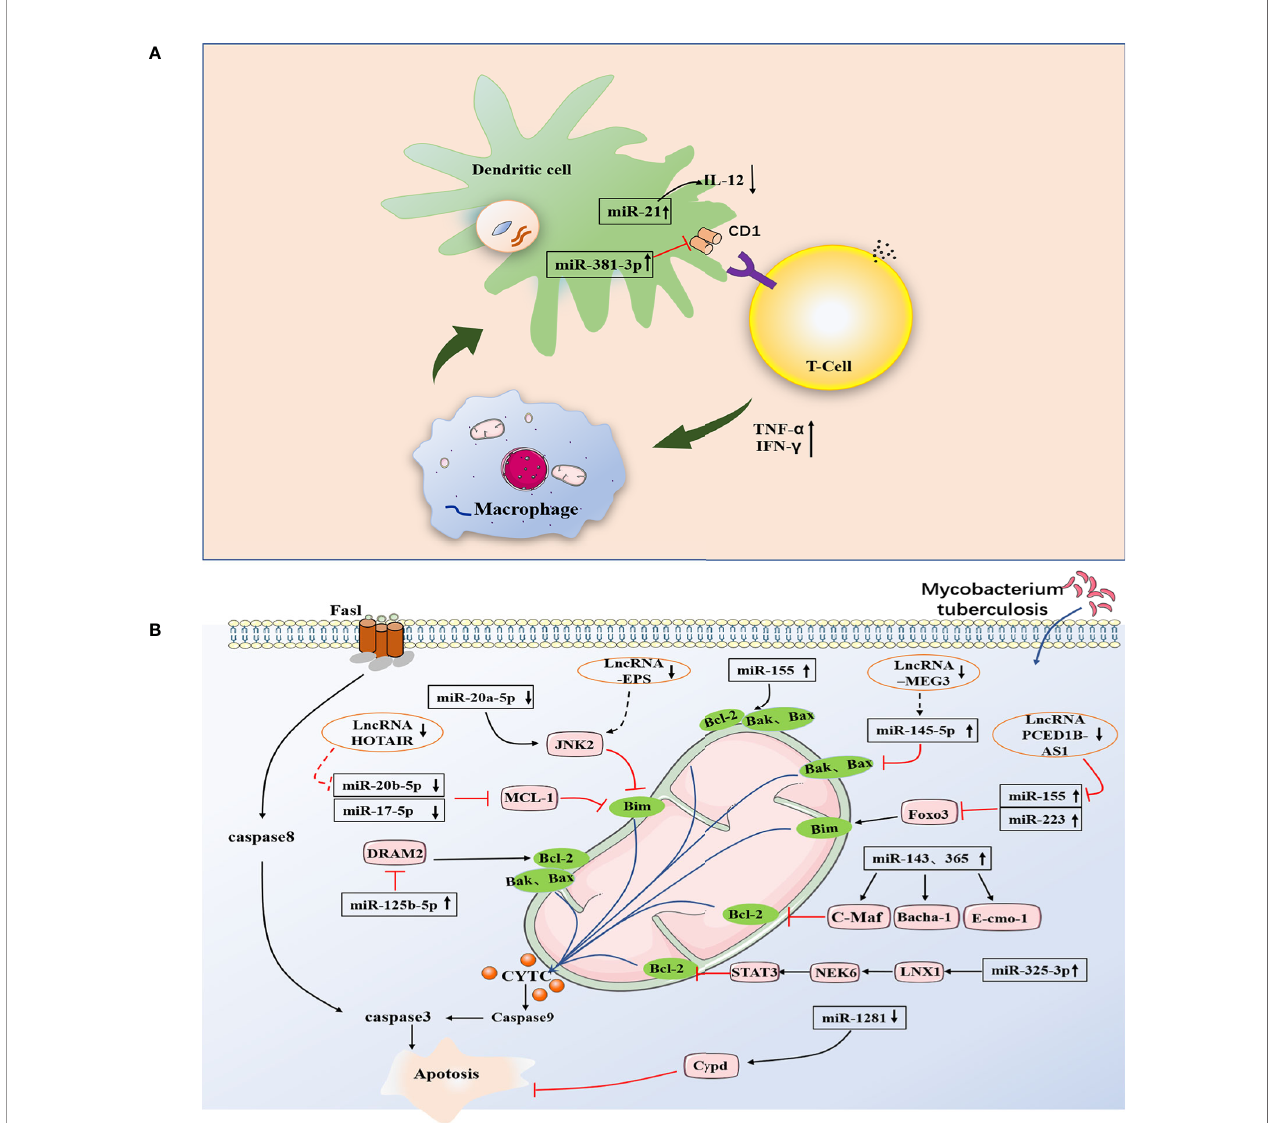
FIGURE 2 | Strategy of non-coding RNA regulating apoptosis pathway in M. tuberculosis infected cells. (A) MiR-155 and miR223 inhibit apoptosis by targeting FOXO3, miR-1281 inhibited apoptosis by targeting cyclophilin-d, miRNA-143 and miRNA-365 inhibit apoptosis by differentially targeting c-Maf, Bach-1, and Elmo-1. MiR-20a-5p negatively modulating Bim expression in a JNK2-dependent manner. MiR-125b-5p target DRAM2 to promot apoptosis, miR-325-3p targets LNX1 (the E3 ubiquitin ligase of NEK6), leading to abnormal accumulation of NEK6, which in turn activates the STAT3 signaling pathway. At the same time, potential ceRNAs are also fl agged here. lincRNA-EPS inhibited apoptosis and enhanced autophagy by activating the JNK/MAPK signaling pathway. PCED1B-AS1 can directly bind to miR-155 to reduce the rate of apoptosis. LncRNA MEG3 can control miR-145-5p expression and regulate macrophage proliferation. The mechanism of action of ceRNA needs to be further studied and veri fi ed. (B) The apoptotic cells present antigen to DCs to trigger T-cell immunity. MiR-381-3p mediate the reduction of CD1c expression, thereby inhibiting T cell immune responses to M. tuberculosis. MiR-21 promotes the apoptosis of DCs by targeting Bcl-2, and inhibits IL-12 production by targeting IL-12p35, weakening the T-cell response to M. tuberculosis . Direct stimulatory modi fi cation; Direct inhibitory modi fi cation; Tentative stimulatory modi fi cation; Tentative inhibitory modi fi